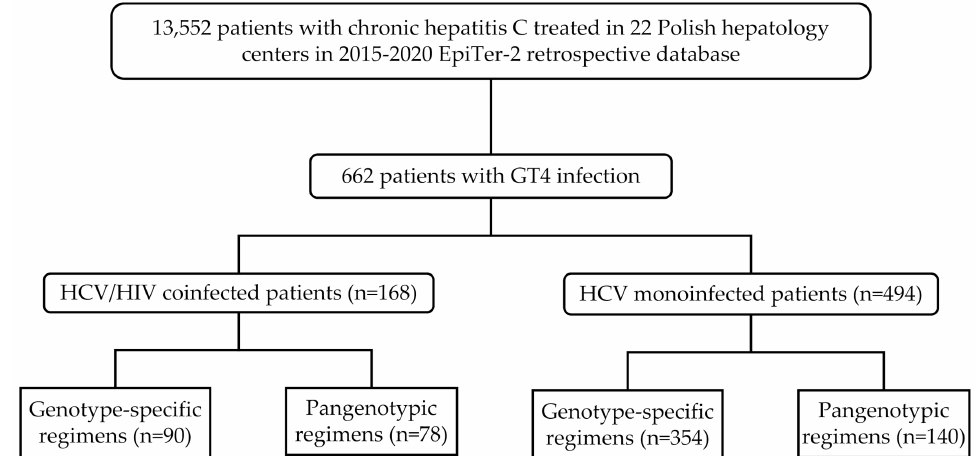
Figure 1. Flow chart showing the selection and stratification of patients included in the